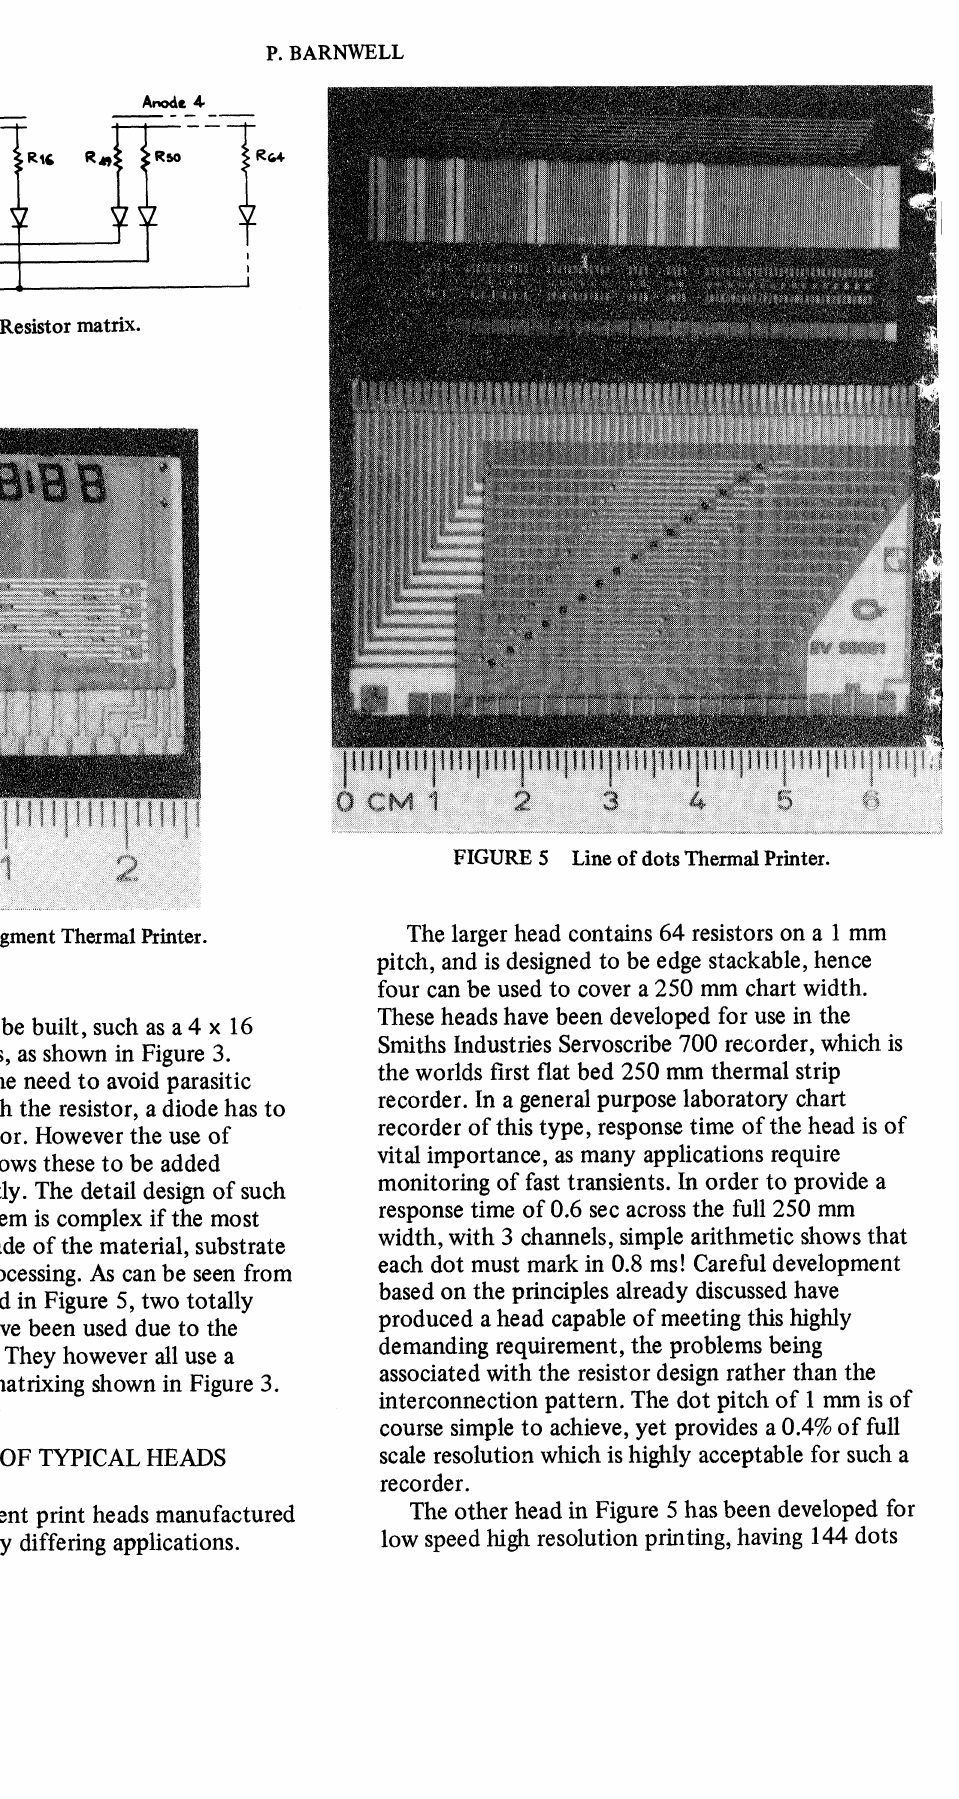
FIGURE 3 64 Resistor matrix.